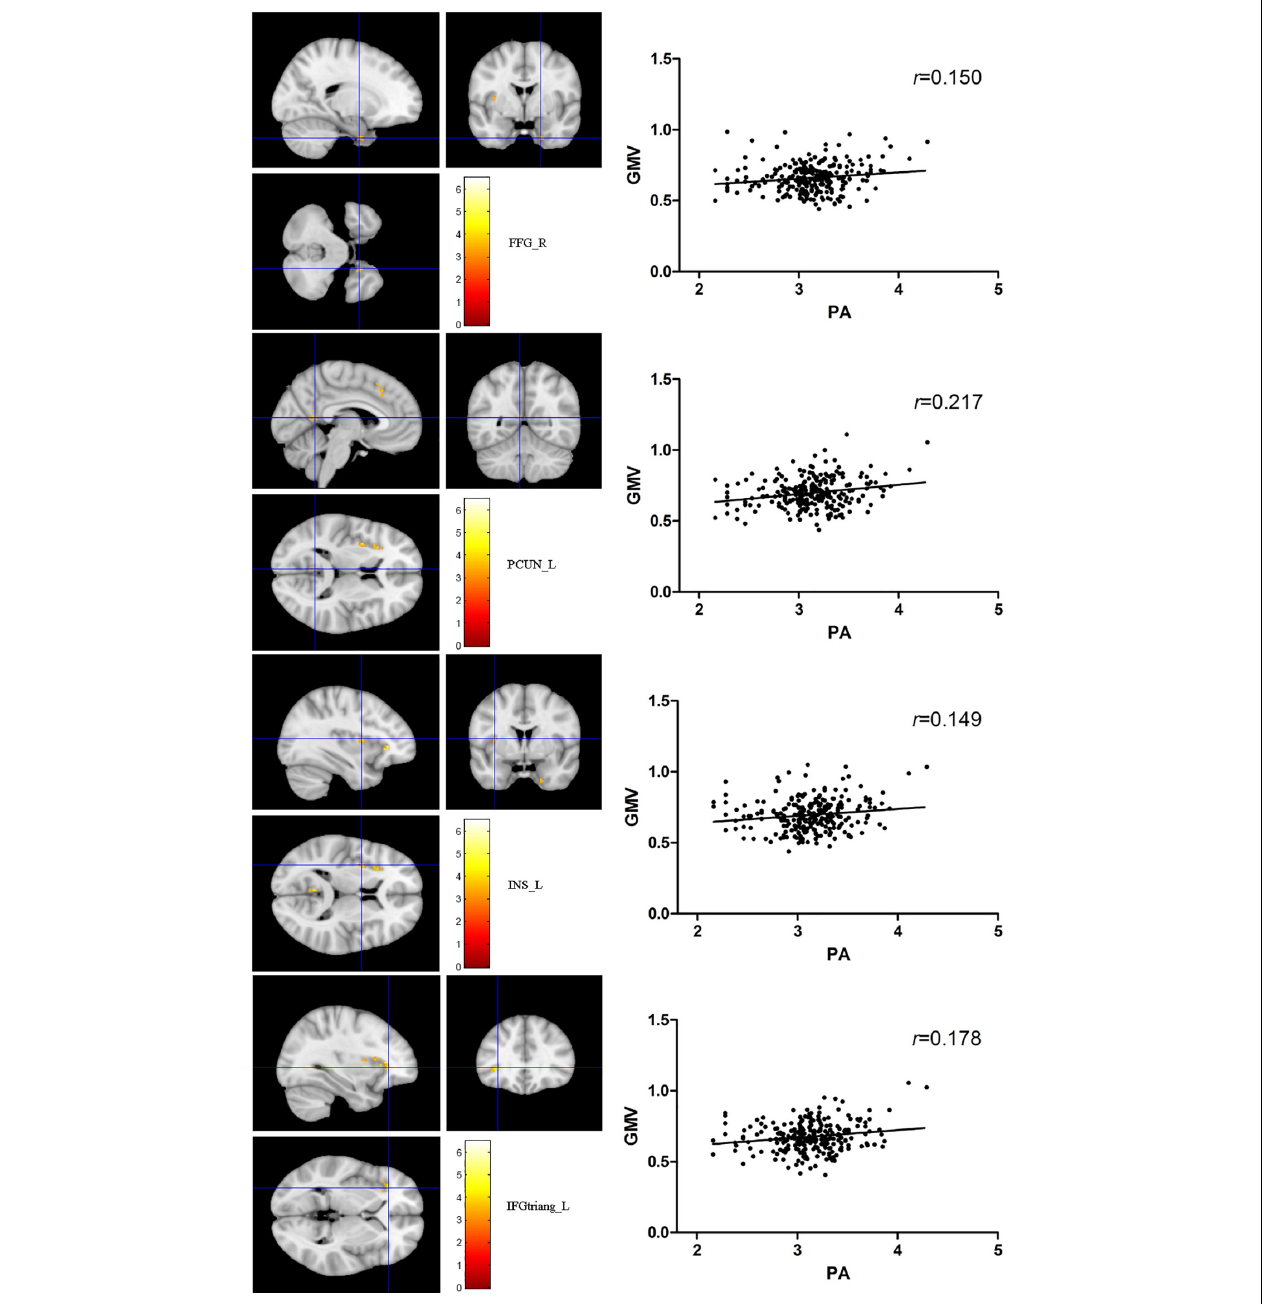
FIGURE 2 | The red-yellow color indicates positive association between total PA MET and gray matter volume (GMV) in the right fusiform gyrus, left precuneus, the left insula (INS), and left triangular part of inferior frontal gyrus. The color scale represents t values. The threshold for displaying was set to p < 0.05, family-wise error